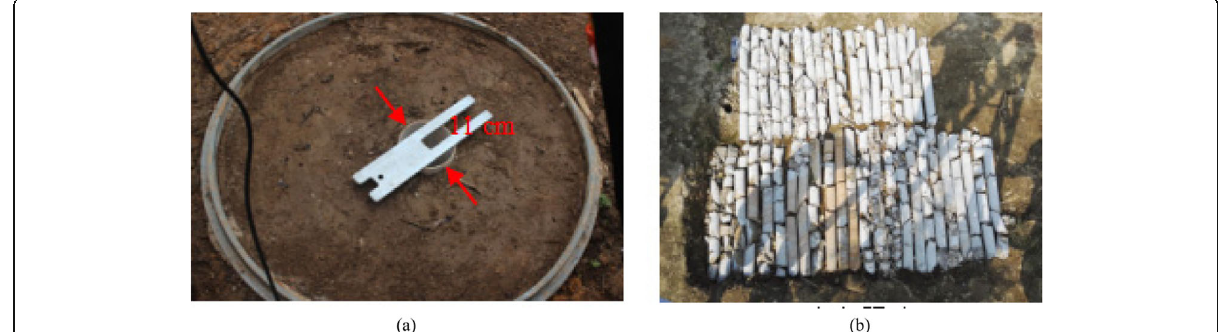
Fig. 15 Close-up photos of wellhead and sample photos of rock core. a Wellhead photos. b Rock core photos